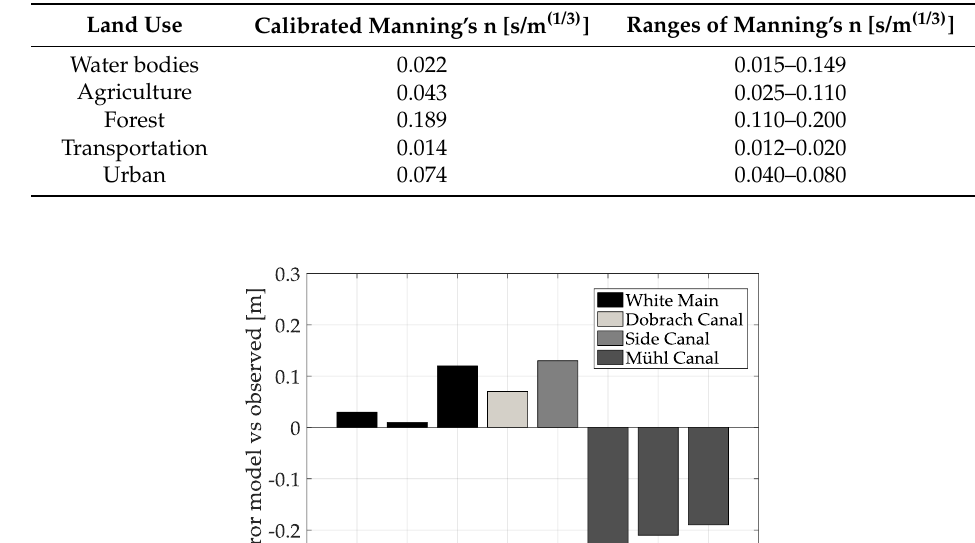
Table 3. Manning’s M for each land use class.